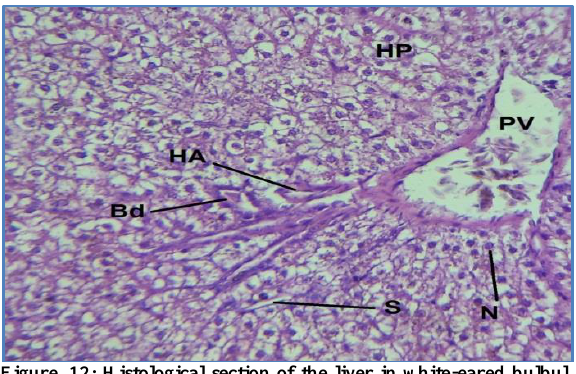
Figure, 12: Histological section of the liver in white-eared bulbul shows, the portal triad. Portal vein (PV), hepatic artery (HA), bile duct (Bd), and sinusoids (S). hepatic plate (HP) (H and E 100X).